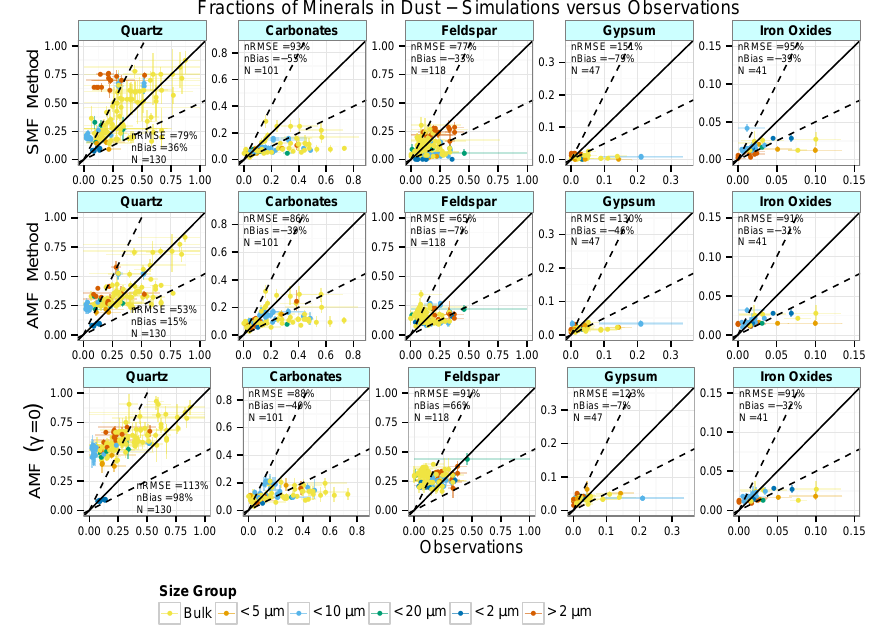
Figure 9. Same as Fig. 4 but including particle mass (PM) measurements at other size